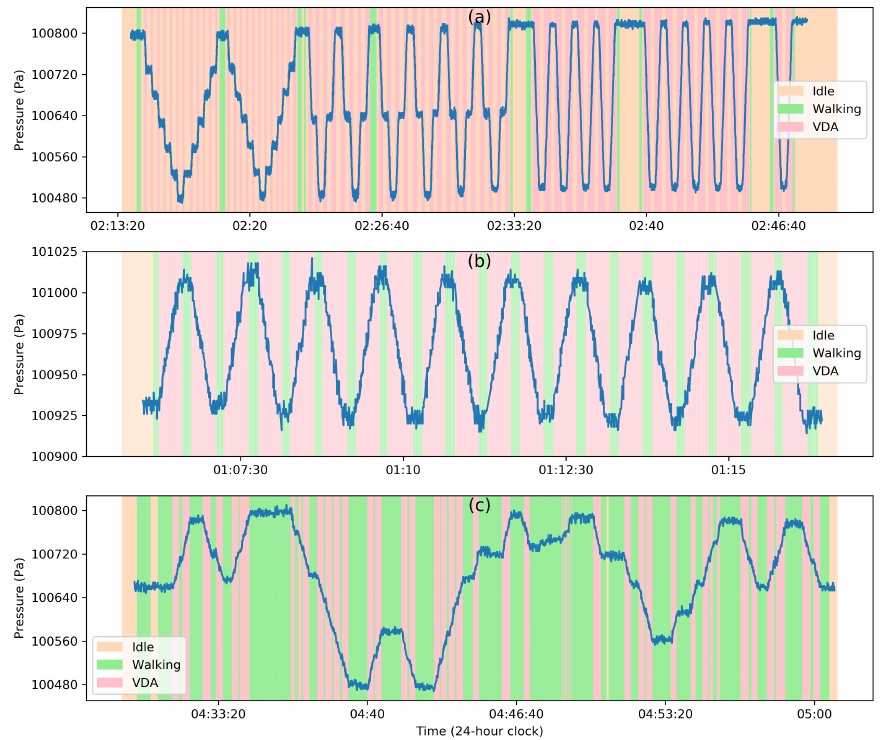
Figure 4. Effects of variations of altitude during human activity and motion on ( a ) an elevator, ( b ) an escalator, and ( c ) stairs. Data were collected by carrying a mobile device with a sampling rate of ∼ 1 Hz on different modes of vertical movement. For panel ( a ), the elevator was intentionally stopped at each floor in the first part of the data collection (before 2:23 a.m.) to show the ability to distinguish single-floor changes. In the second part (between 2:23 a.m. and 2:33 a.m.), only one stop was made between the first and last floor. Finally, the last part of the data (after 2:33 a.m.) corresponds to an uninterrupted elevator ride between the first and last floor. The data in panel ( b ) were collected by continuously climbing and descending on the same two-way escalator, and the data in panel ( c ) were collected while using stairs. The escalator climb and descent in panel ( b ) correspond to an average relative pressure difference of 80.7 Pa with a standard deviation of 3 Pa, thus showing the accuracy in recording relative pressure changes. Moreover, the relative pressure of 80 Pa corresponds to a height of 6.6 meters according to Equation (1), thus close to the measured height of 7.3 meters and within the equivalence sensor resolution of ± 1 meter. The data in panel ( c ) were collected by a human subject performing a series of floor jumps (climbing, descending, and walking) in three interconnected campus buildings: floor 3 to 1 (4:32 a.m.), 1 to 3, 3 to 1, 1 to 7 (4:40 a.m.), 7 to 5, 5 to 7, 7 to 1 (4:46 a.m.), 1